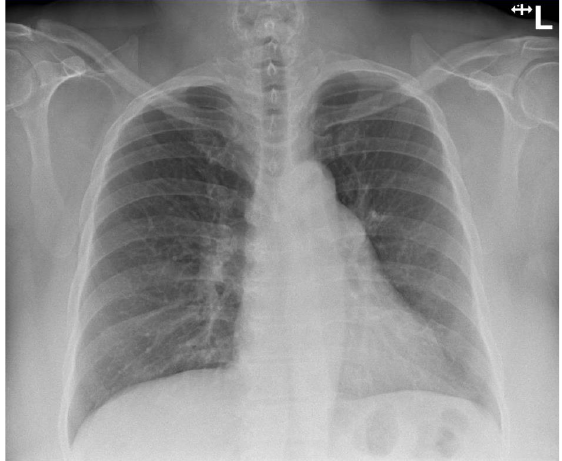
Figure 2. Normal chest X-ray radiograph on admission.